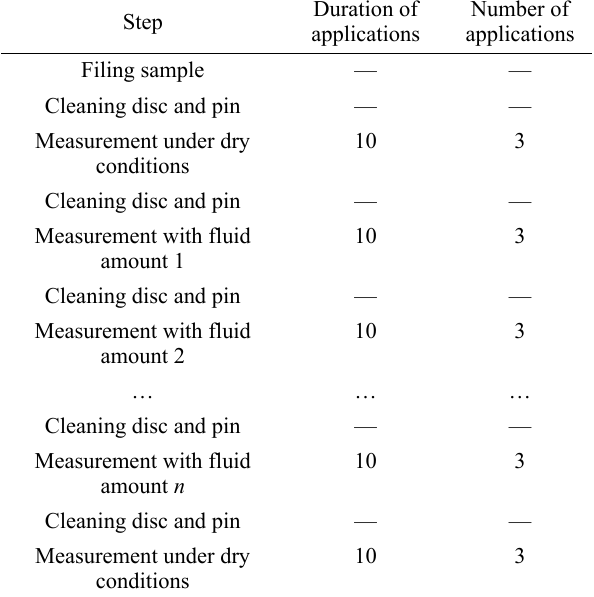
Table 1 Measurement